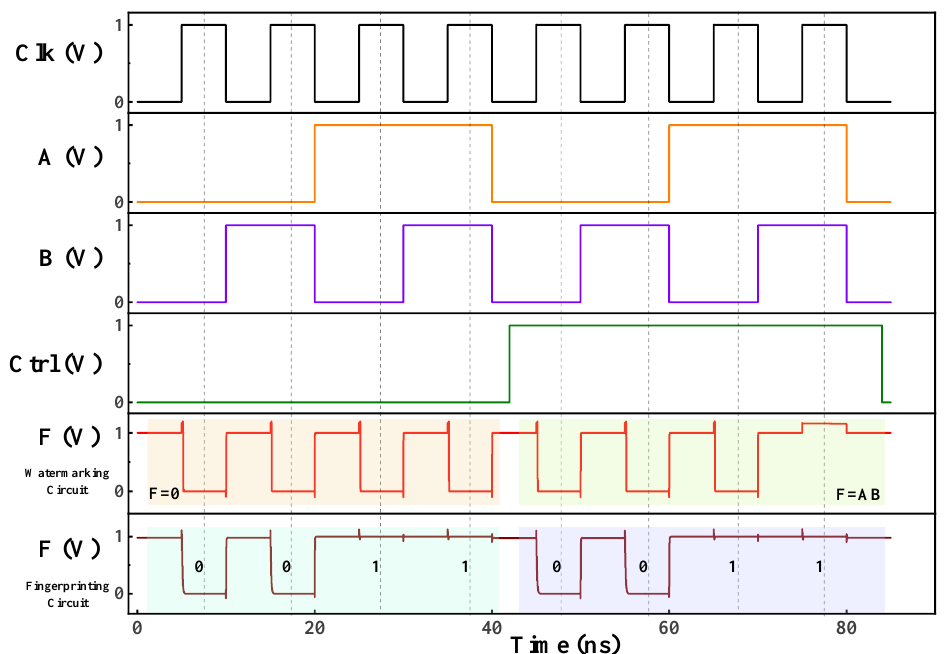
Figure 7. Variation of delay with width of tail NMOS transistor of PCSA for SOT-based ( a ) XOR operation. ( b ) NAND operation.